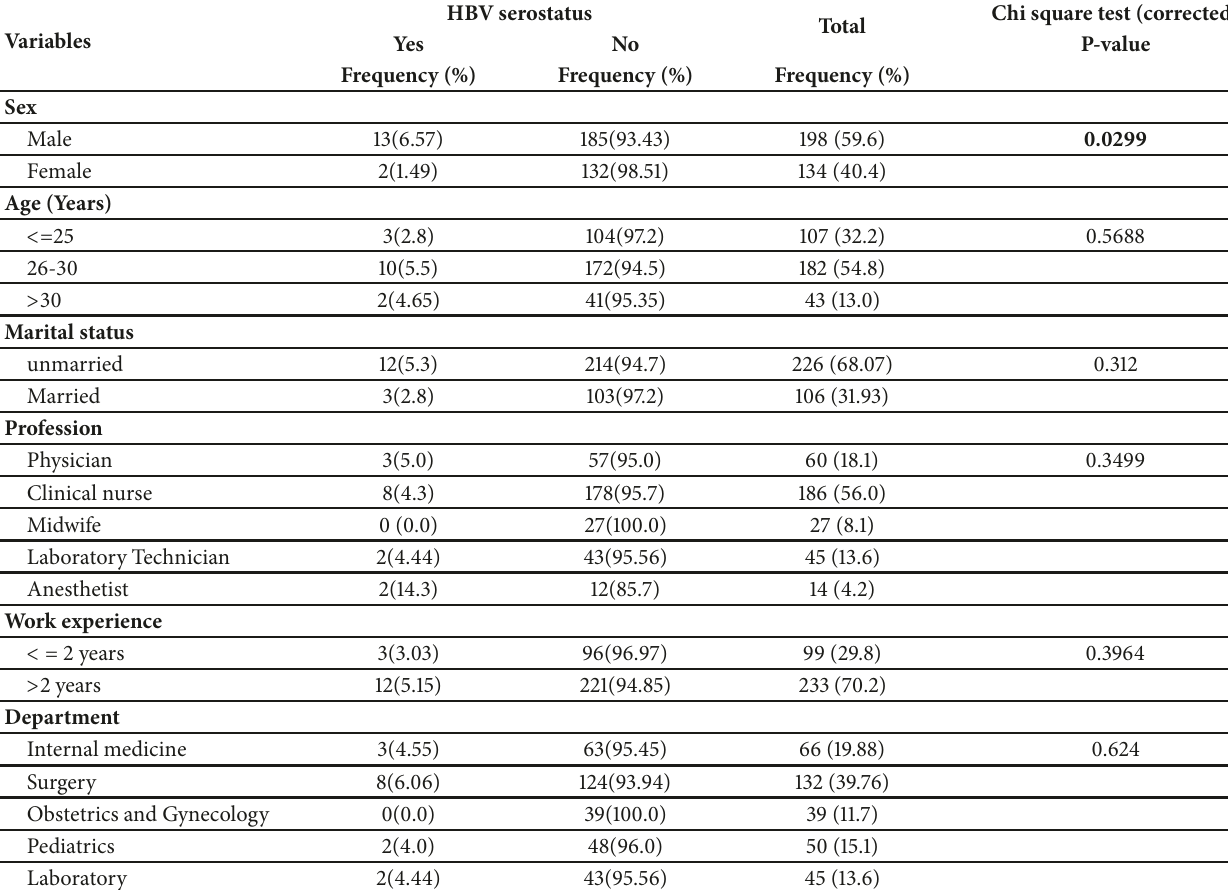
Table 2: The prevalence of HBV among health professionals by sociodemographic variables at University of Gondar Hospital, Northwest Ethiopia,